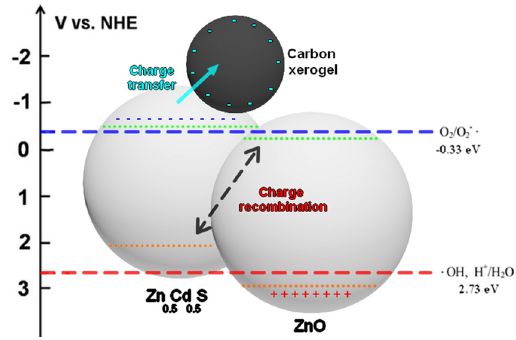
Figure 12. Schematic representation of the heterojunctions present in the XC/ZnO-Zn